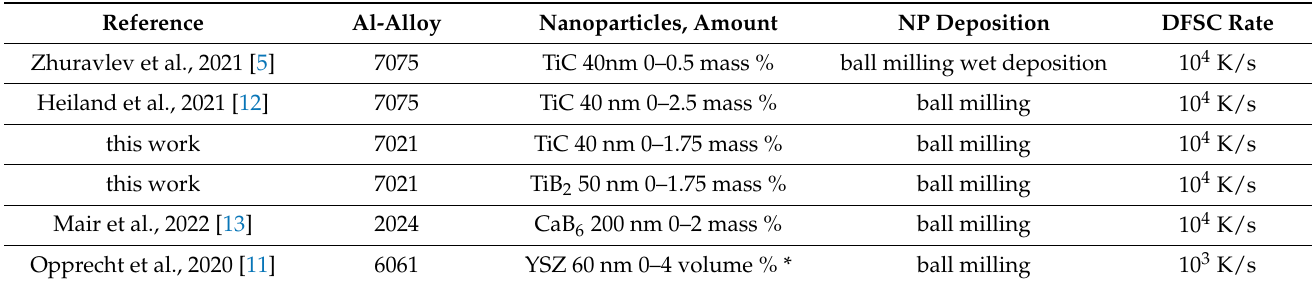
Table 2. Investigated aluminium alloys, nanoparticles and references.